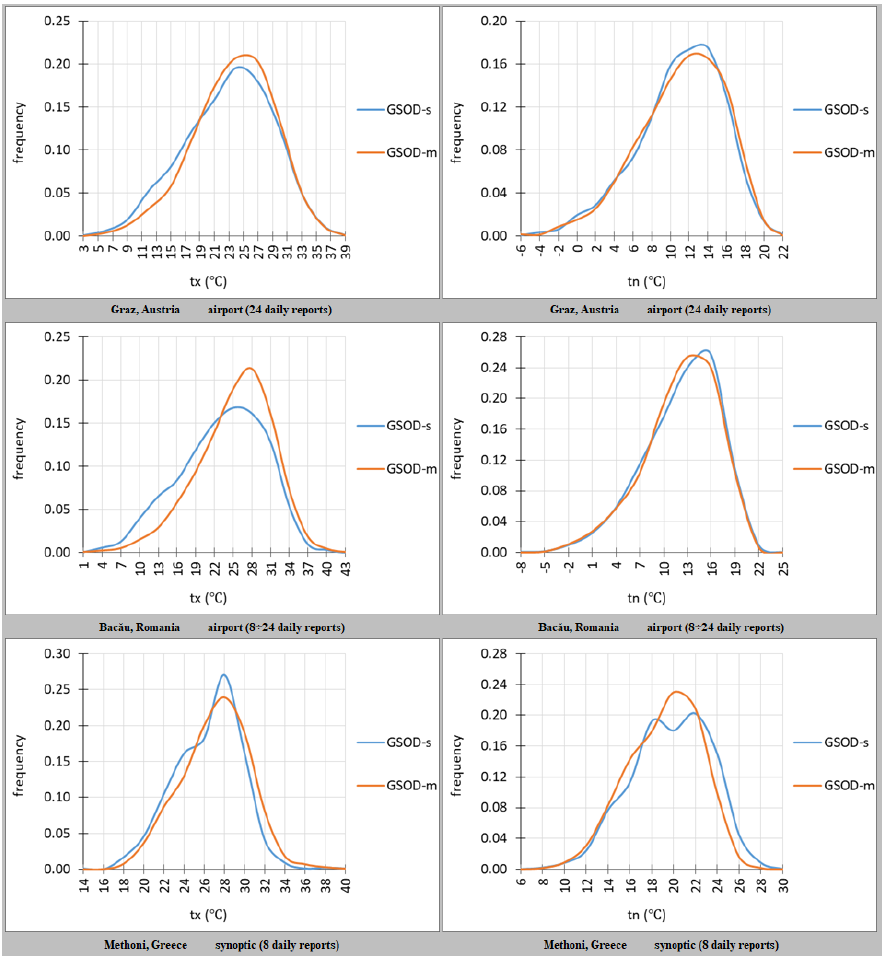
Figure A1. Comparison between samples of measured maximum/minimum temperatures (GSOD-m) and substituted maximum/minimum temperatures (GSOD-s) for the warm half year (May–October) by stations with different climates, environments, and observational routines; tx —daily maximum temperature, tn —daily minimum